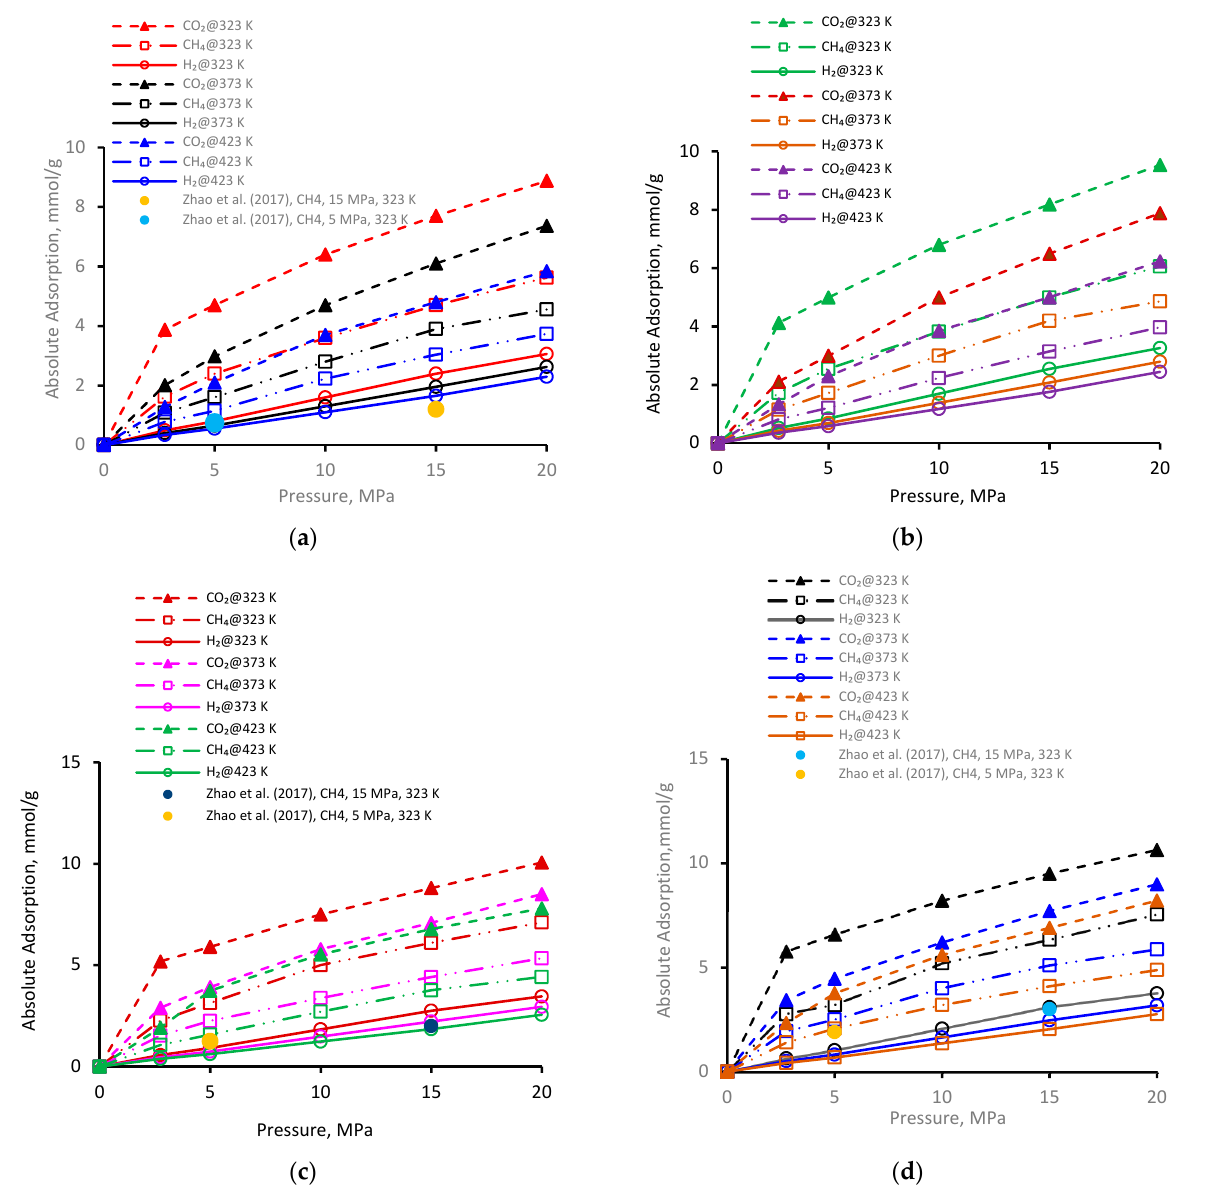
Figure 1. Gas adsorption behavior versus pressure at different temperatures on kerogen [52]; ( a ) II-A, ( b ) II-B, ( c ) II-C, ( d ) II-D.